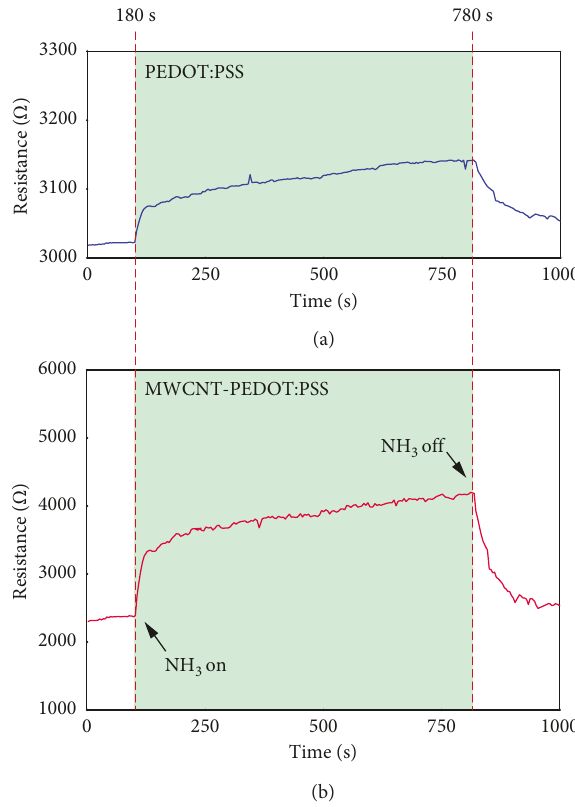
Figure 11: Resistance changes of the gas sensors prepared by inkjet printing exposed to 1000ppm NH 3 with (a) bare PEDOT:PSS and (b) MWCNT-PEDOT:PSS as sensing